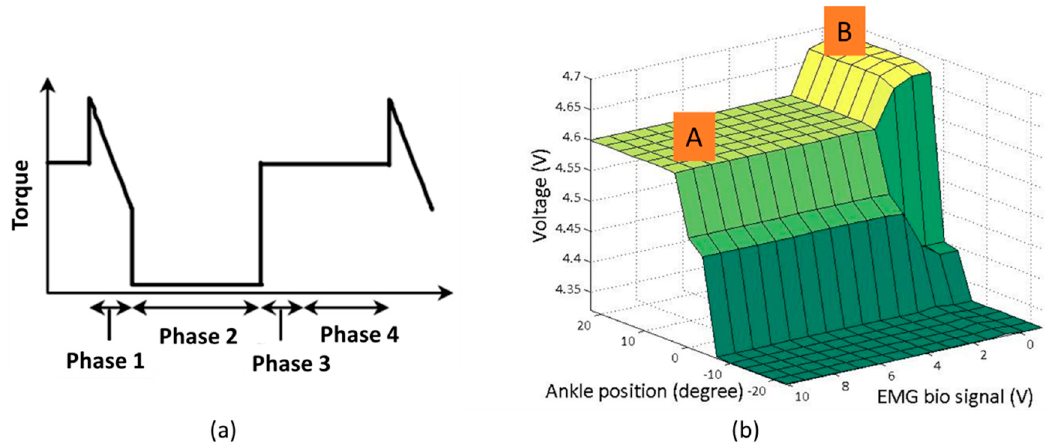
Figure 9. Torque references. ( a ) Fixed output reference [41]; ( b ) Fuzzy output reference